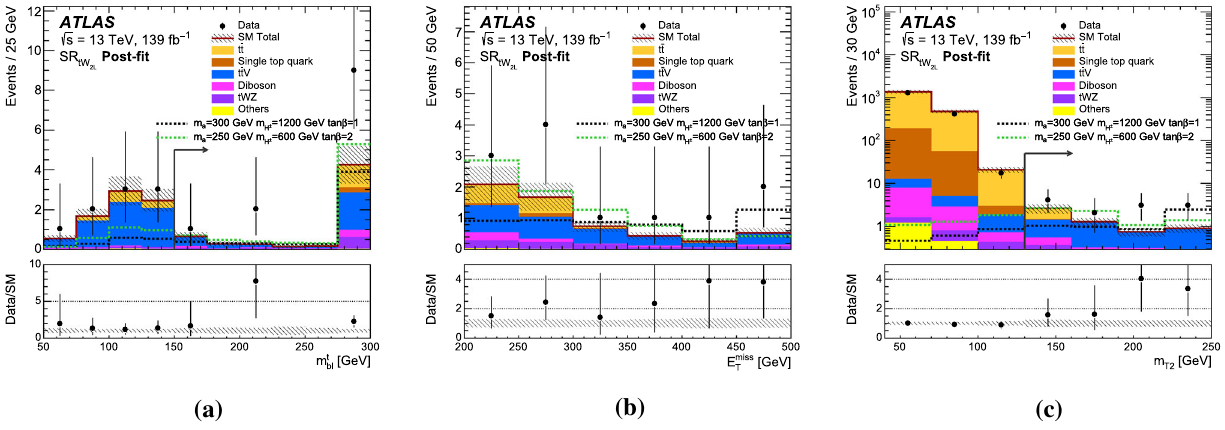
Fig. 11 Representative distributions of a m t , b E miss and c m T2 in the such as triboson, t ¯ tt ¯ t , t ¯ tWW , and Higgs boson production processes. b (cid:7) T tW 2L channel. Observed data are compared with the SM background The expected distributions for representative scenarios with different m a , m H ± , and tan β are shown for illustrative purposes. The overflow predictionsextrapolatedfromthebackground-onlyfit.AllSRselections events,wherepresent,areincludedinthelastbin.Thelowerpanelsshow except the one on the quantity shown are applied. The SR requirement the ratio of data to the background prediction. The hatched error bands is indicated by the arrow. As the m t is defined for events with at least b (cid:7) indicate the combined experimental and MC statistical uncertainties on two jets, the events with exactly one jet are included in the overflow these background predictions bin. The ‘Others’ category includes contributions from rare processes